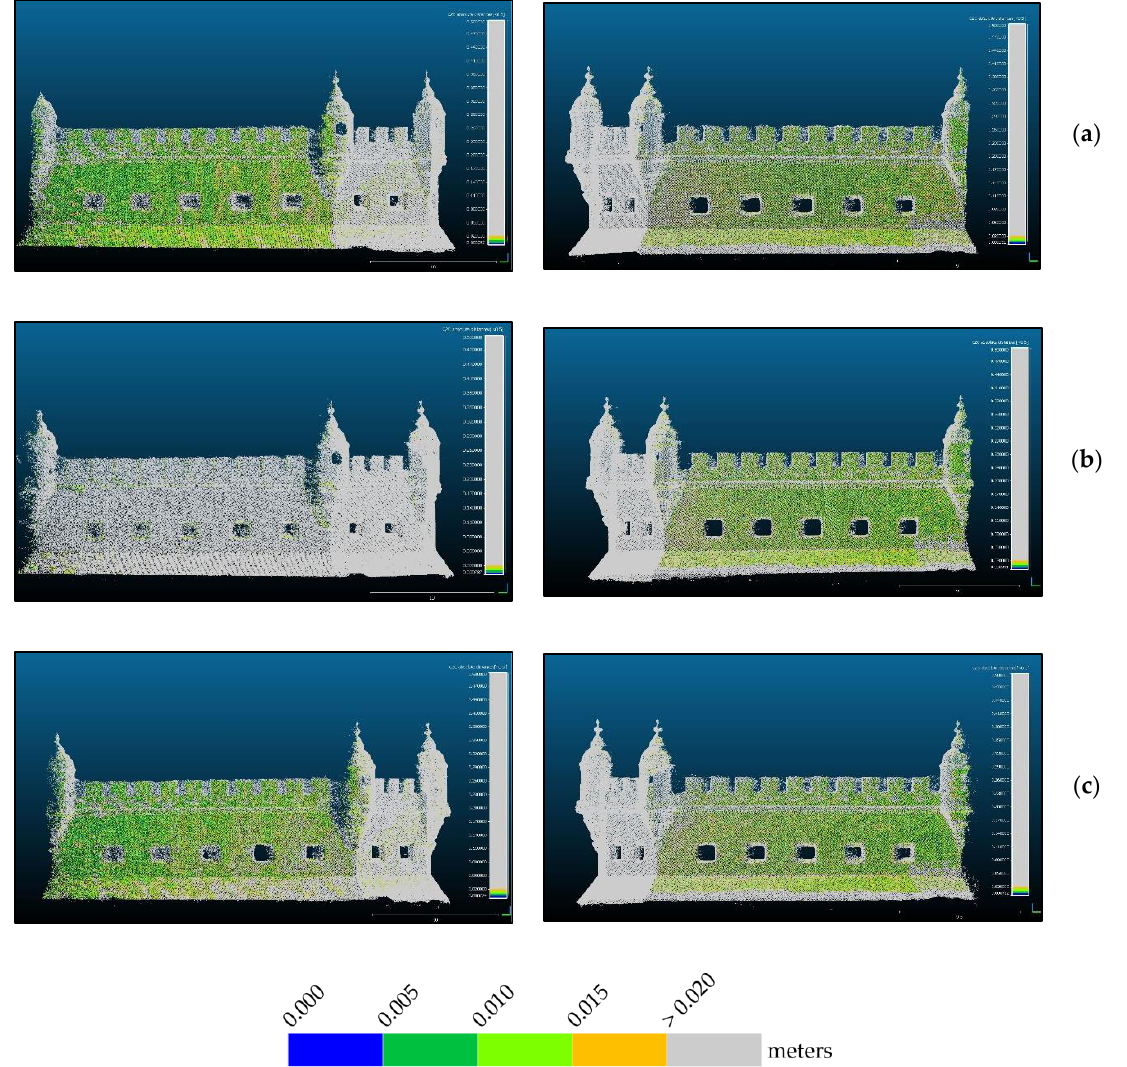
Figure 17. Distribution of points where residuals are smaller than 2 cm: (left) West bulwark façade; (right) East bulwark façade. ( a ) ICP; ( b ) Total station points; ( c ) TLS points.